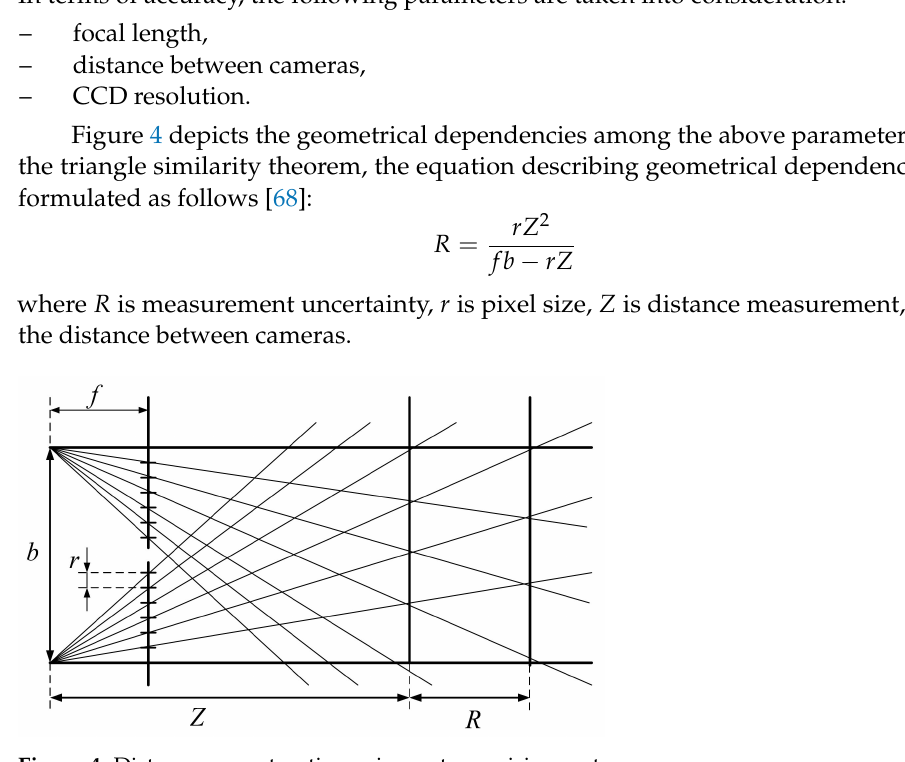
Figure 4. Distance reconstruction using a stereo vision